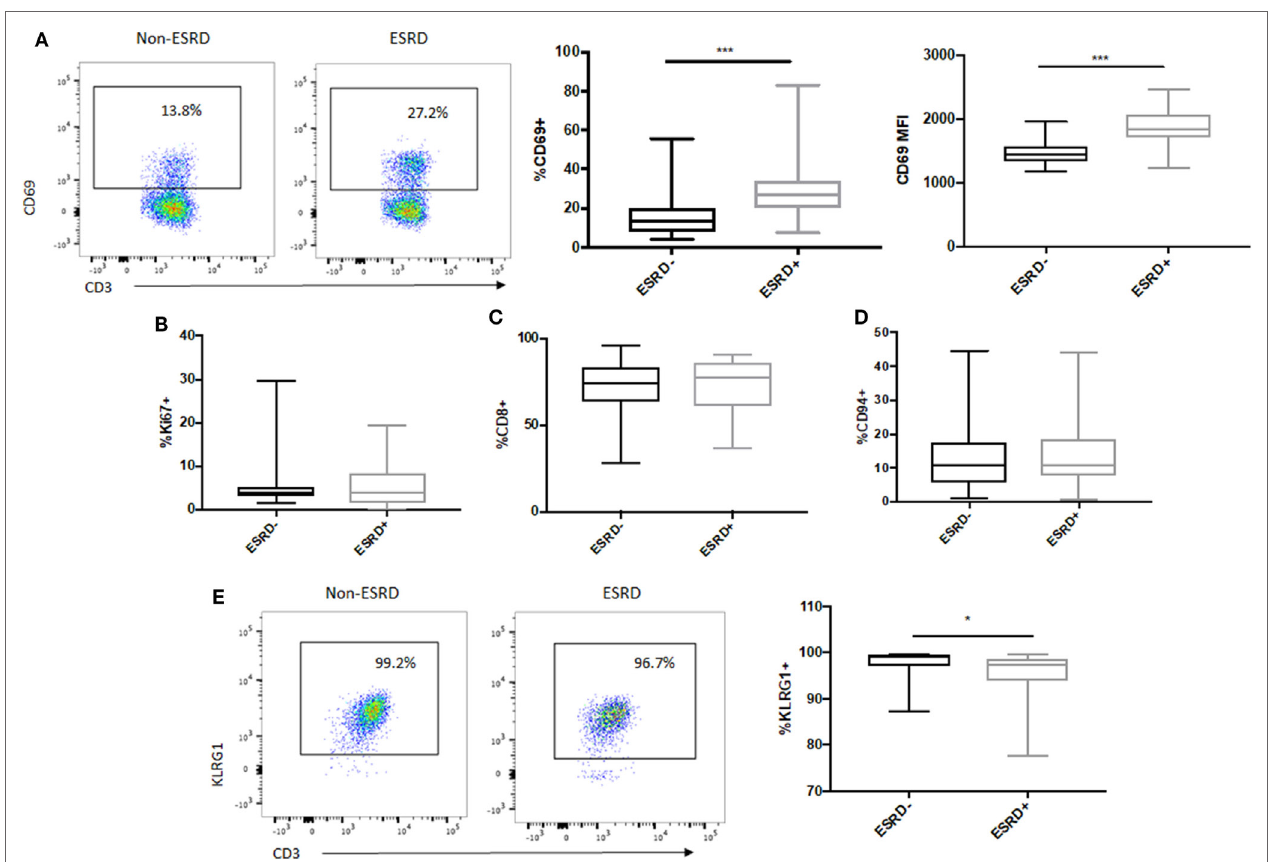
FigUre 3 | Ex vivo mucosal-associated invariant T (MAIT) activation and NK cell receptor expression. (a) Representative staining of the acute activation marker CD69 on control ( n = 20) and end-stage renal disease (ESRD) ( n = 19) MAIT cells (V α 7.2 + CD26 ++ CD161 ++ ). CD69 expression was significantly elevated among the ESRD group compared to healthy controls. (B) Comparable expression of Ki67 on MAIT cells among ESRD ( n = 17) and non-ESRD ( n = 16) controls. (c) The majority of MAIT cells in both groups were CD8 + ( n = 20 control, n = 19 ESRD). (D) A small but consistent proportion of MAIT cells in both study groups expressed CD94 ( n = 18 non-ESRD, n = 17 ESRD). (e) Representative staining of KLRG1 expression on MAIT cells in controls ( n = 16) and ESRD participants ( n = 17), which exhibited significantly lower KLRG1 expression. Comparisons performed by Mann–Whitney test, * p < 0.05, *** p <